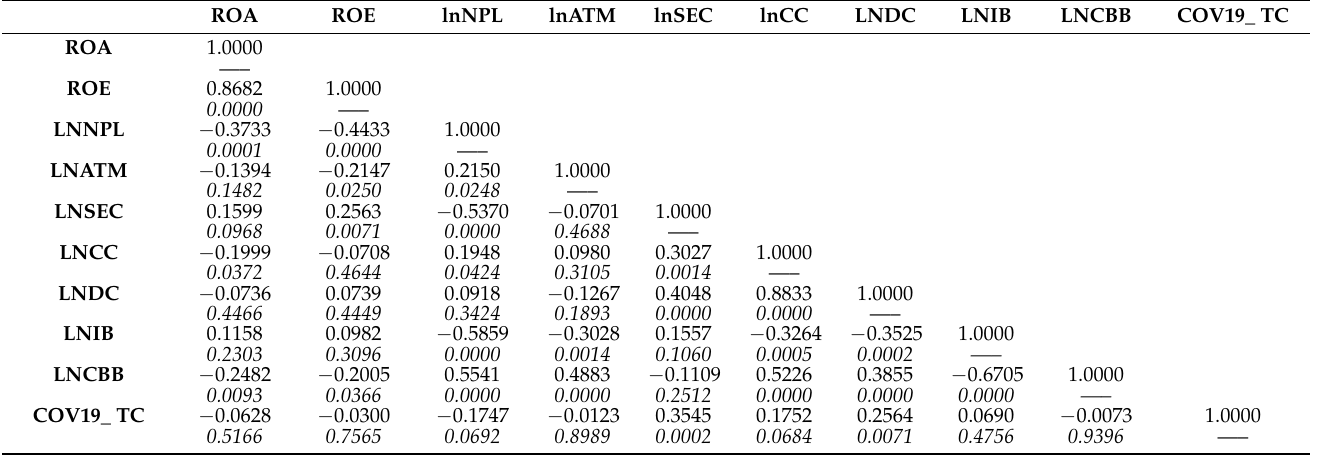
Table 2. Correlation